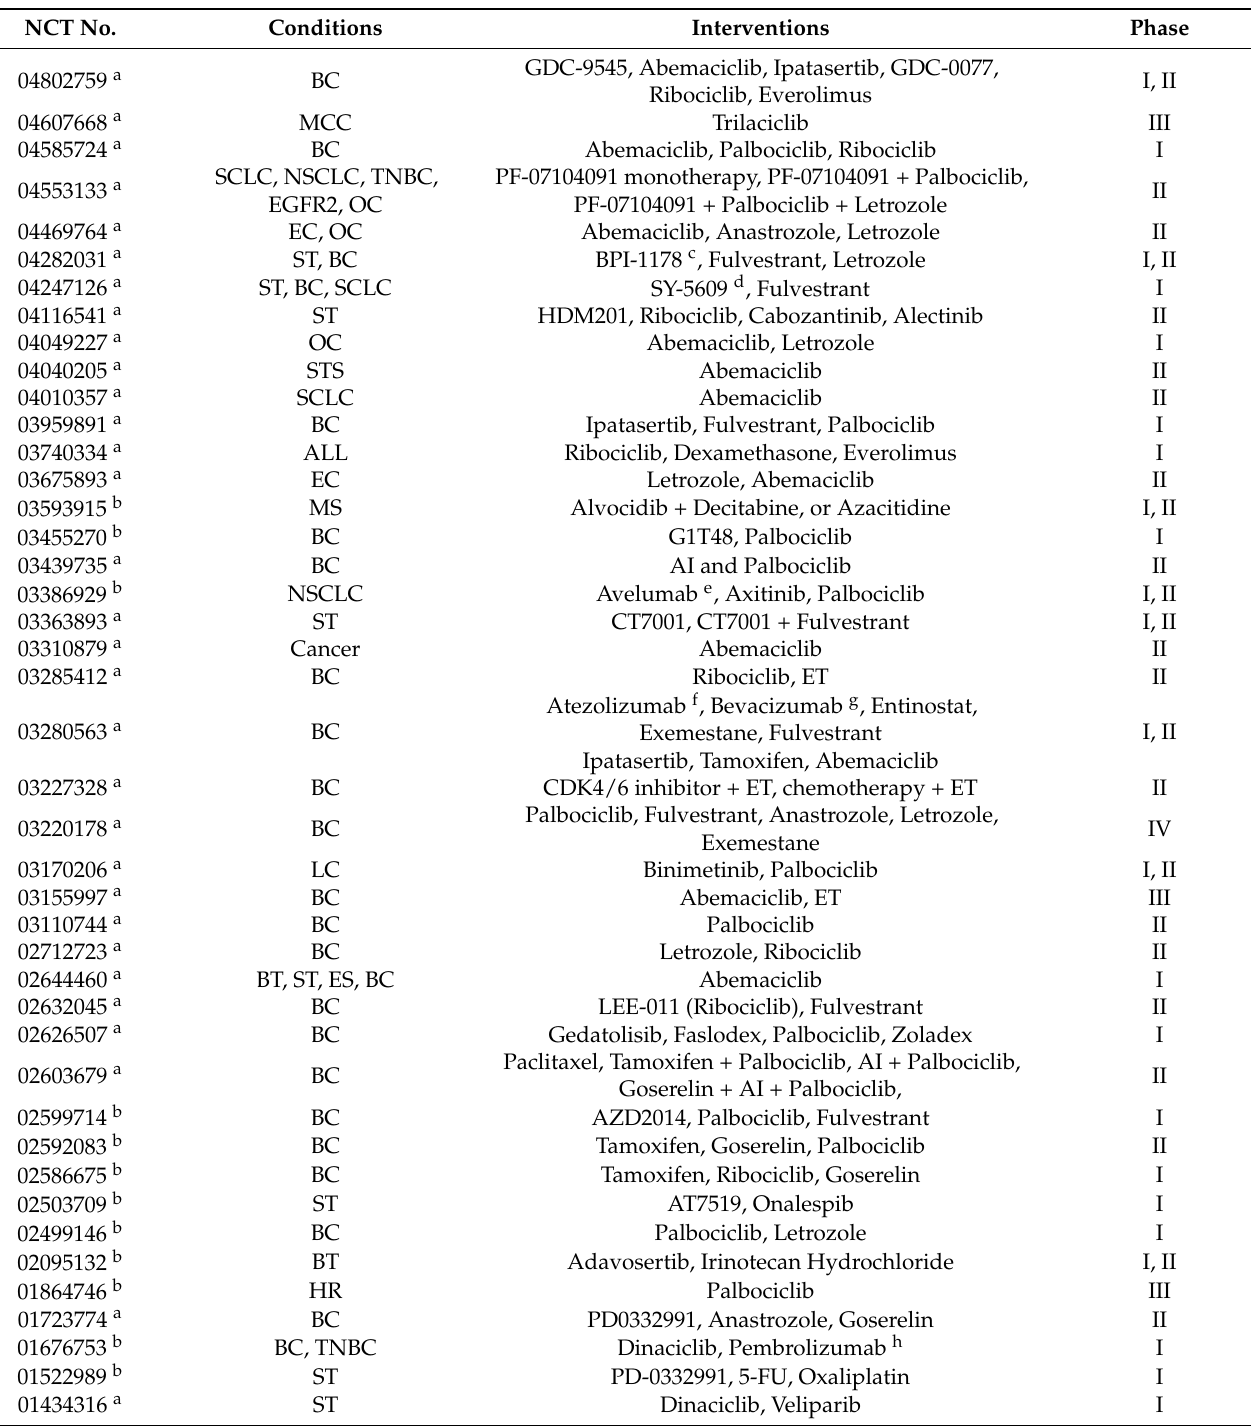
Table 1. CDK inhibitors in clinical